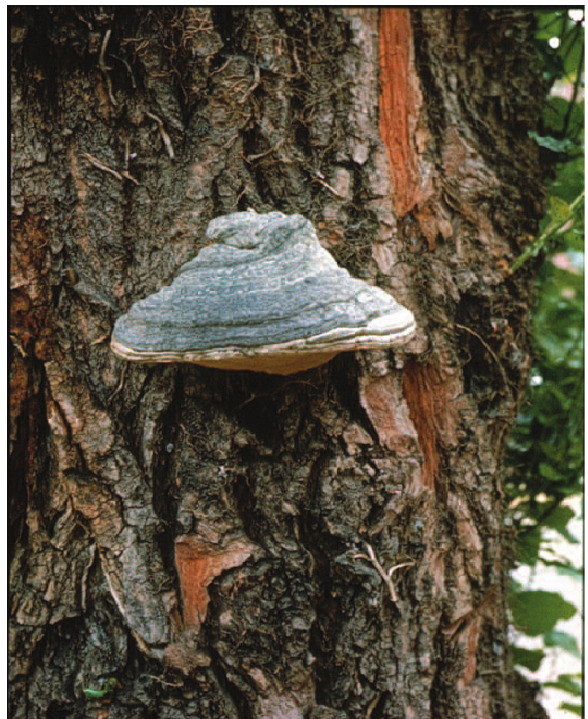
Fig. 2. Carpophore of the true esca fungus, Fomes fo- mentarius on a beech tree. Photo Gilberto Govi, Bolo- gna, Italy.